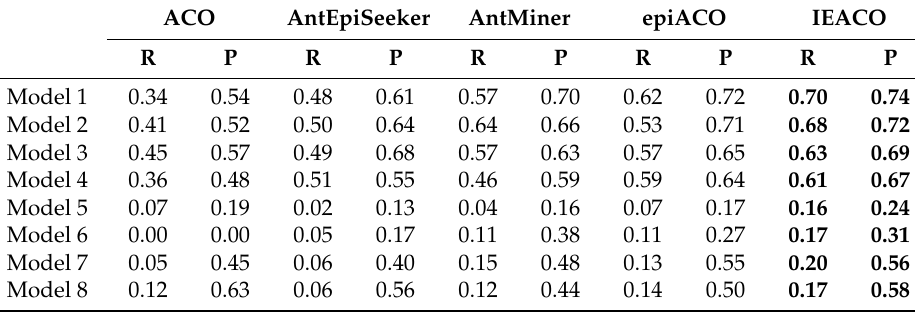
Table 4. Results of recall and precision on 5000-SNP